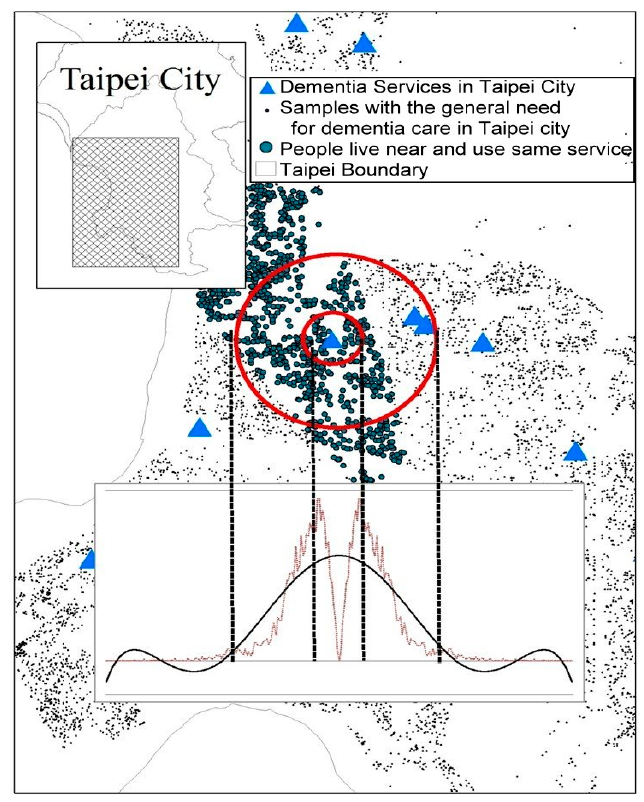
Figure 2. Relative spatial relationship between service users and providers: Taking Taipei City as an example.